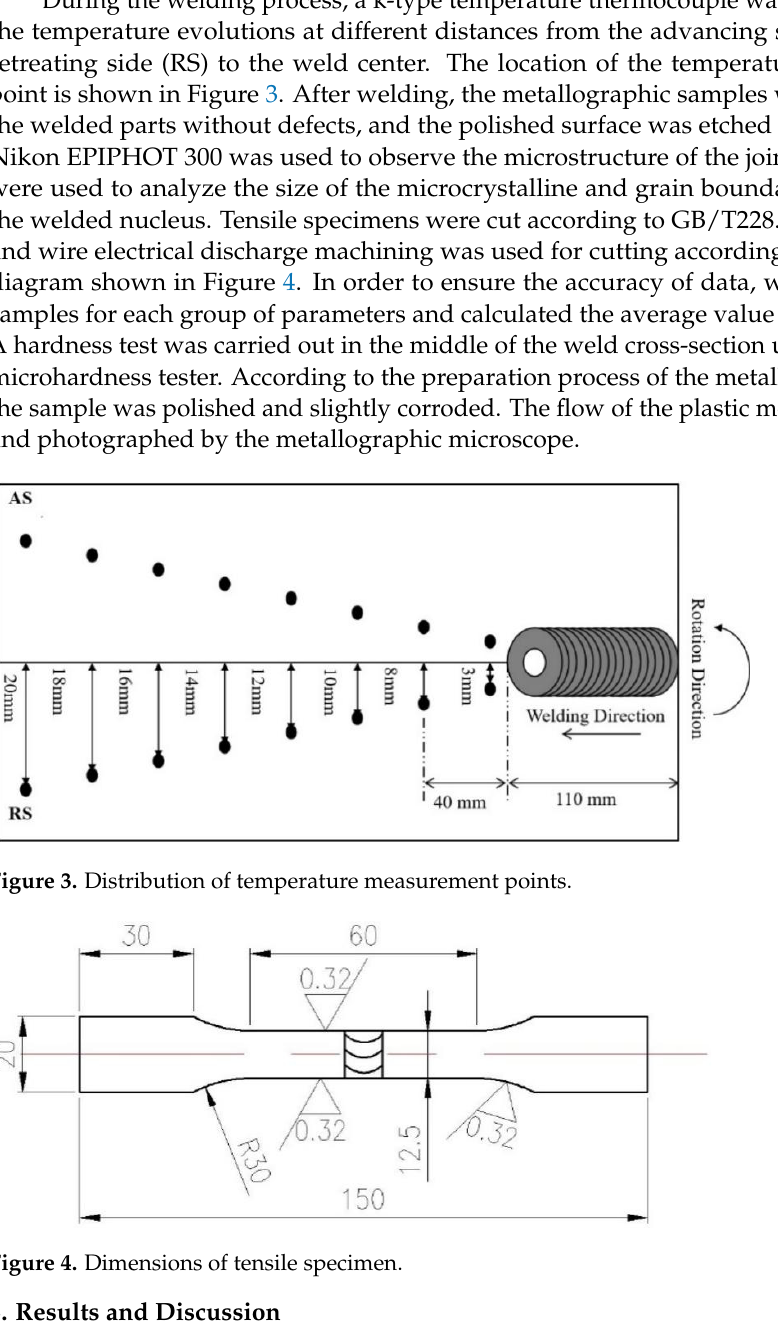
Table 2. Chemical composition of 6061 aluminum alloy (mass fraction/%) . Figure 2. Geometries of three kinds of tool pins: ( a ) actual shapes of pins, ( b ) conical thread, ( c ) conical cam thread.